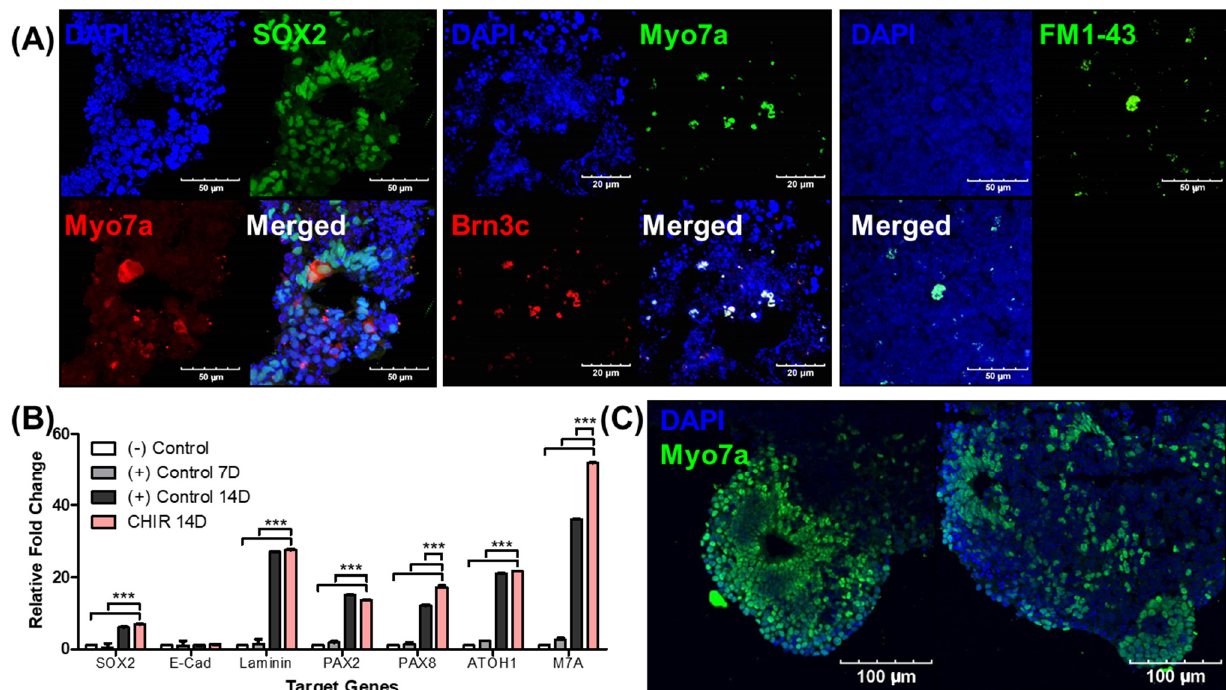
Figure 5. Epifluorescence analysis of organoids and the effect of a Wnt agonist (CHIR) on myosin VIIa expression. We conducted epifluorescence analysis of the organoids from enucleated EBs on differentiation day 30 to measure the hair cell markers, as demonstrated in ( A ). The organoids with mature protrusions were frozen and sectioned. The left image shows myosin VIIa- and Sox2-positive cells in an organoid. Cellular spaces were observed within the organoids. Most of these spaces were surrounded by myosin VIIa (red; inner ear hair cell marker)- and Sox2 (green; inner ear-supporting cell marker)-positive cells. The middle image shows the diffuse expression of myosin VIIa (red)-positive cells and Brn3c (green; another inner ear hair cell marker)-positive cells. Co-expression of myosin VIIa and Brn3c was also observed. The right image shows the expression of FM1-43, which is a marker for mechanoelectrical transduction. ( B ) The results of a RT-PCR analysis of gene expression in accordance with otic differentiation. The negative control (( − ) Control) corresponds to EBs before differentiation, (+) Control 7D to EBs on differentiation day 7, (+) Control 14D to EBs on differentiation day 14, and CHIR 14D to EBs with CHIR on differentiation day 14. The graph shows statistically significant differences between CHIR 14D and other time points/conditions. The expression of Pax8 (otic precursor marker) and myosin VIIa ( M7A ) was significantly higher with CHIR compared to (+) Control 14D. The image in ( C ) shows two EBs after 30 days of differentiation with CHIR application. Increased expression of myosin VIIa (green; Myo7a)-positive cells was identified, suggesting enhancement of the otic differentiation process. The scale bars in images ( A , C ) indicate different lengths. (*** p < 0.001).